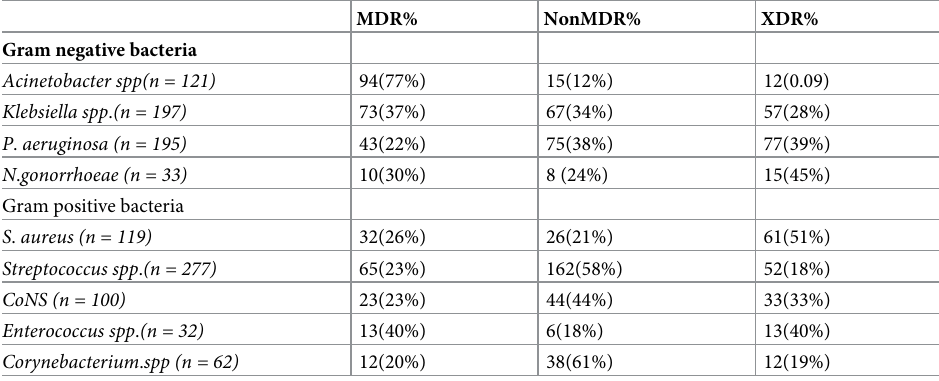
Table 4. Determination of MDR, NonMDR and XDR in bacterial